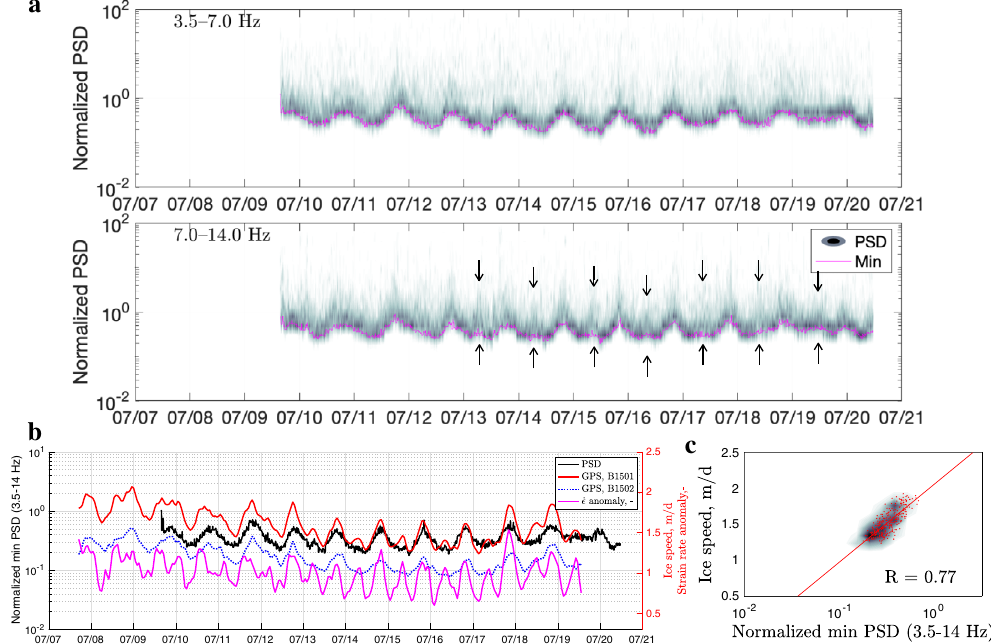
Fig. 5 Analysis of the 2015 on-rock seismic station (CFH). a Density plots of the normalized noise amplitude variations for 3.5 – 14.0 Hz frequency bands (for velocity power spectral density, PSD). Each magenta curve marks the lowest noise level in a given frequency band. Black arrows indicate examples of the morning peaks. The colour scale is the same as in Fig. 2c (0 – 35). b Minimum seismic tremor amplitude (3.5 – 14.0 Hz) versus glacier displacement rate at Global-Positioning-System (GPS) stations B1501 and B1502, with the corresponding strain rate anomaly, _ ϵ (i.e., deviation from the mean). c Scatter and density plots showing the correlation between the seismic signal and horizontal GPS displacement rate at B1501 for overlapping data ( R is the Pearson correlation coef fi cient). The red line is the regression fi